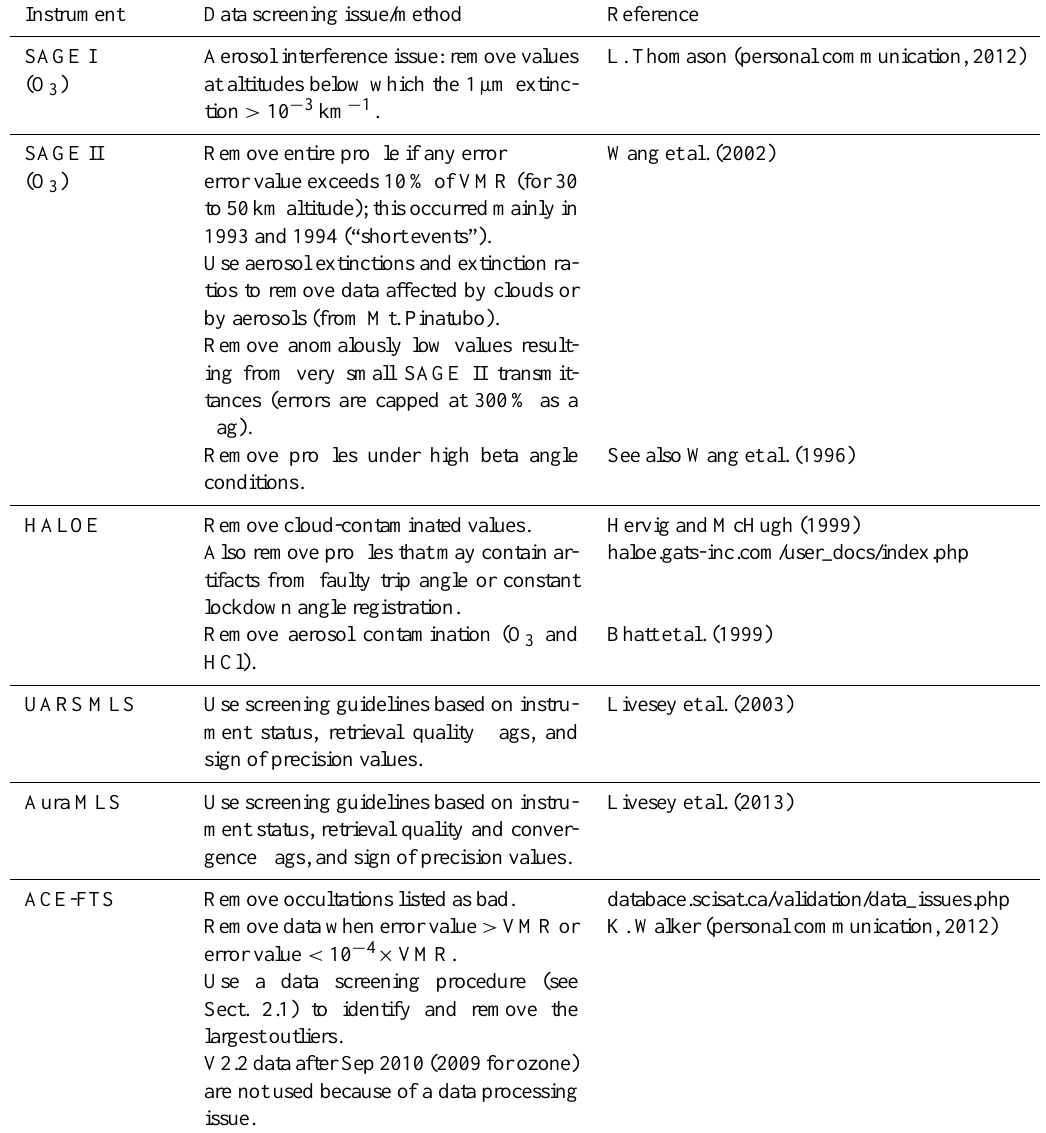
Table A1. Data screening procedures and related references used for the source data set